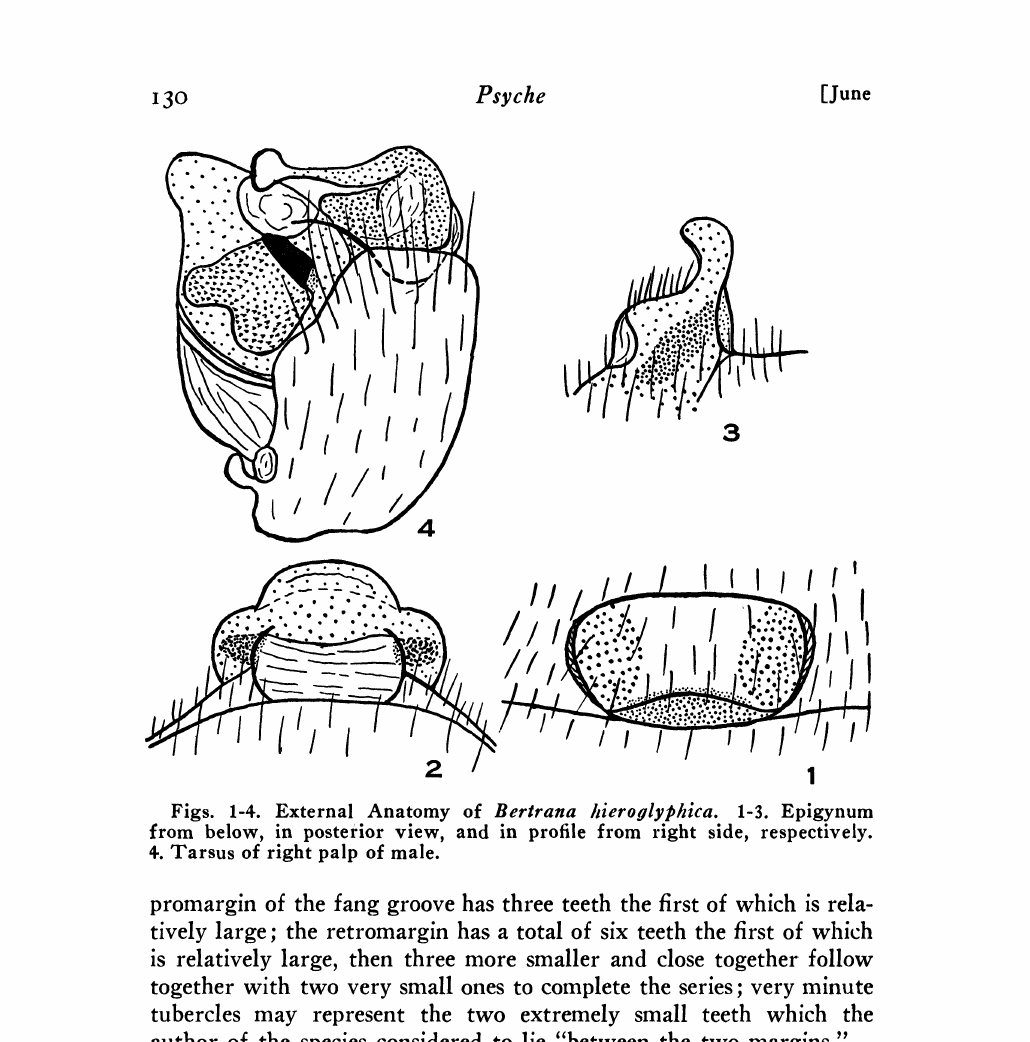
Figs. 1-4. External Anatomy .of Bertrana hieroglythica. 1-3. Epigynum from below, in posterior view, and in profile from right side, respectively. 4. Tarsus of right palp of